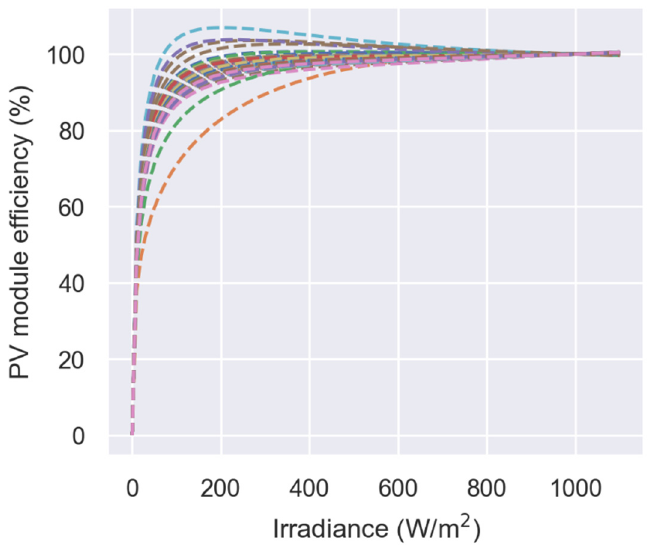
Figure 4. Heydenreich et al. model fitted curves of 107 different Fraunhofer CalLab measurement results for module efficiency at different irradiance levels.